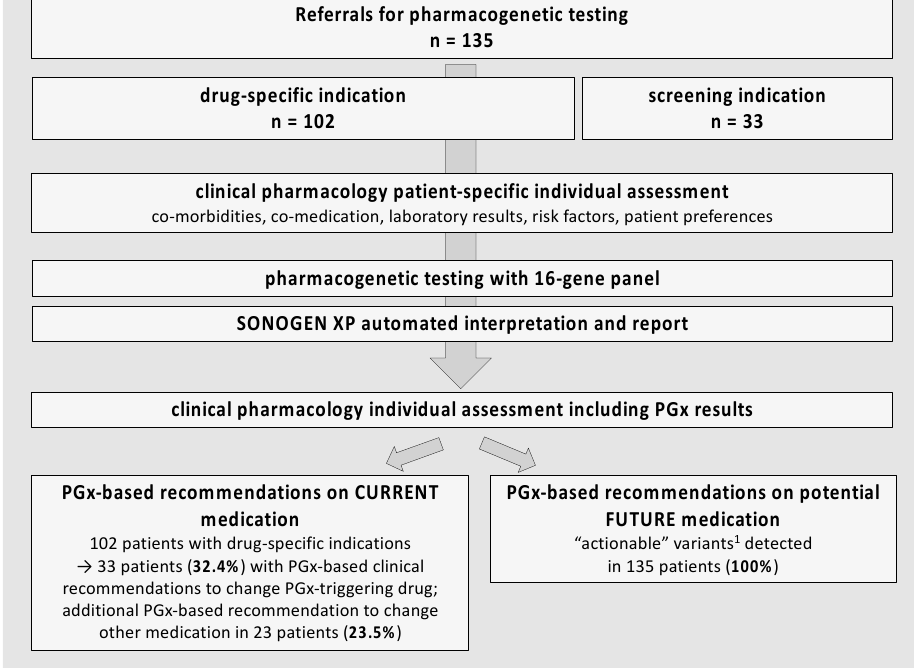
Figure 1. Study population and flowchart. 1 Formally classified as “actionable” according to SONOGEN XP based on PharmGKB guidelines.